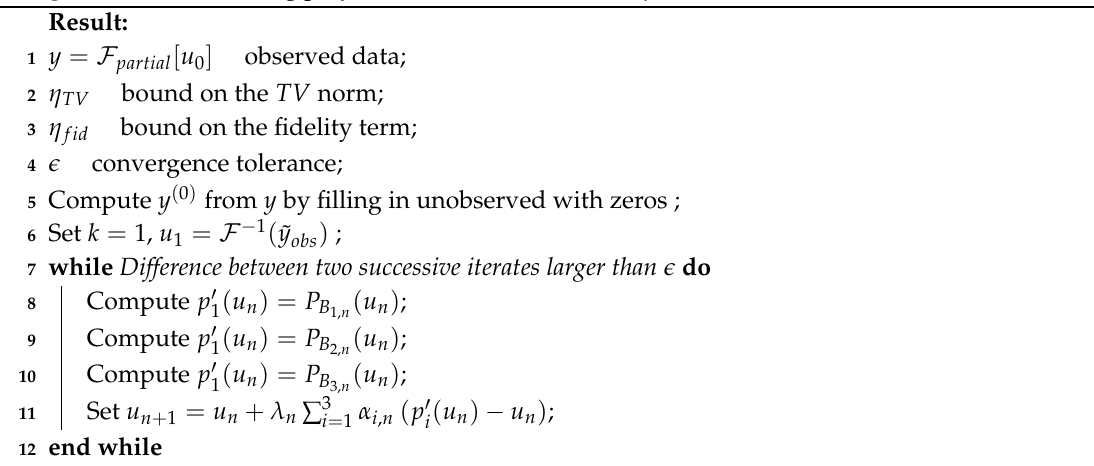
Algorithm 1: Alternating projection method for MRI for p = 1.